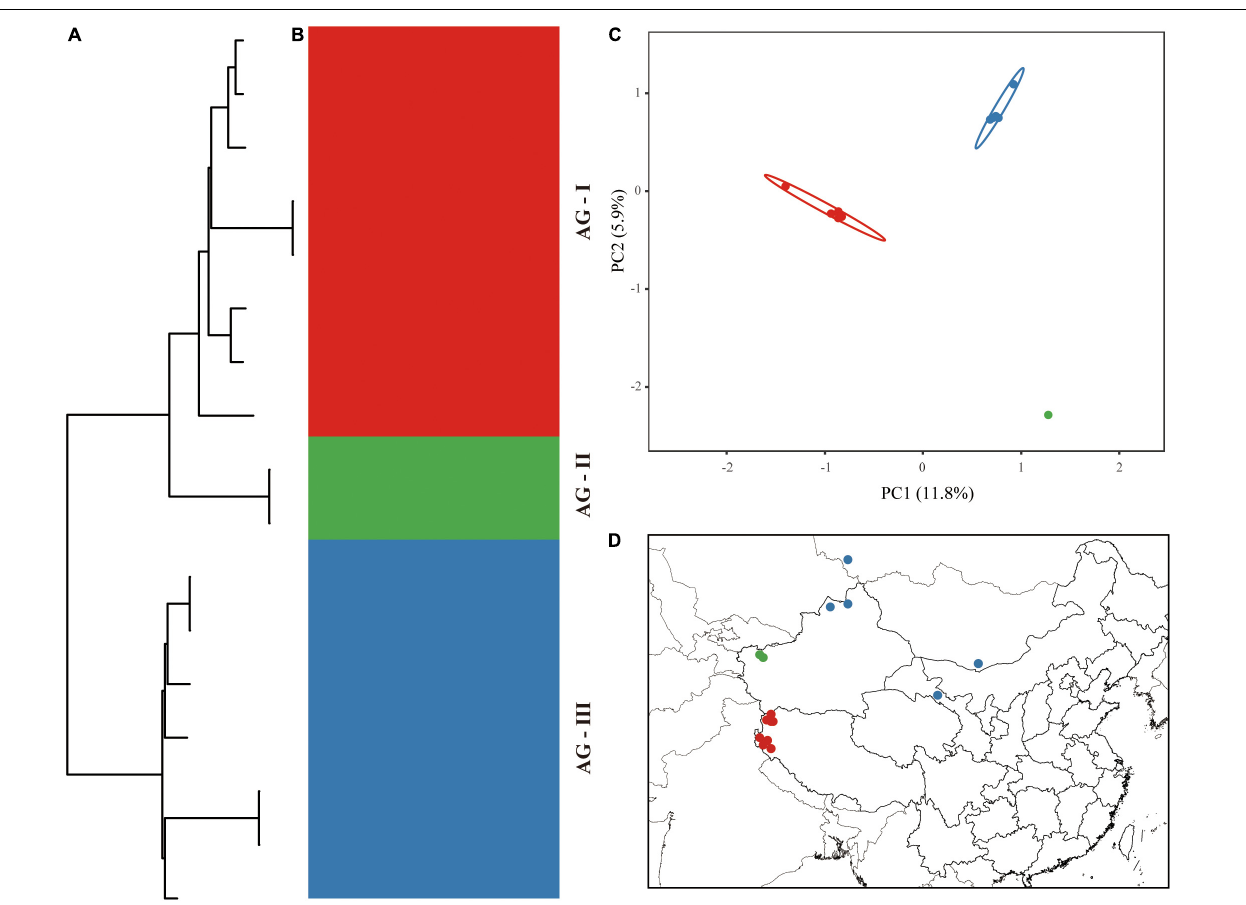
FIGURE 7 | Intraspecific diversity and genetic structure of 17 A. guttata genotypes based on whole chloroplast genomes. (A) Phylogenetic tree; (B) population structure analysis with K = 3; (C) principal component analysis; (D) geographical distribution